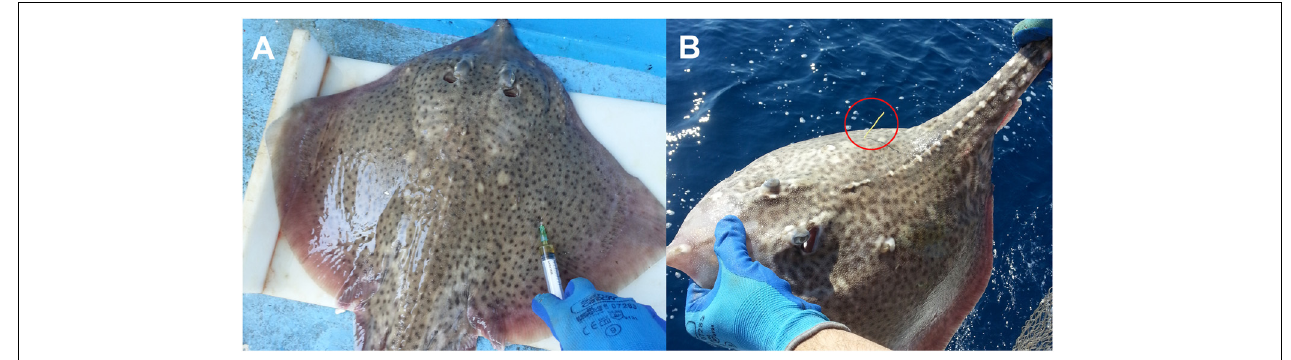
FIGURE 3 | Tagging with a spaghetti tag and oxytetracycline injection. The applied spaghetti tag is marked with a red circle. Tagging with a spaghetti tag and oxytetracycline injection. (A) Tagging with a spaghetti tag and oxytetracycline. (B) The applied spaghetti tag (marked with a red circle).